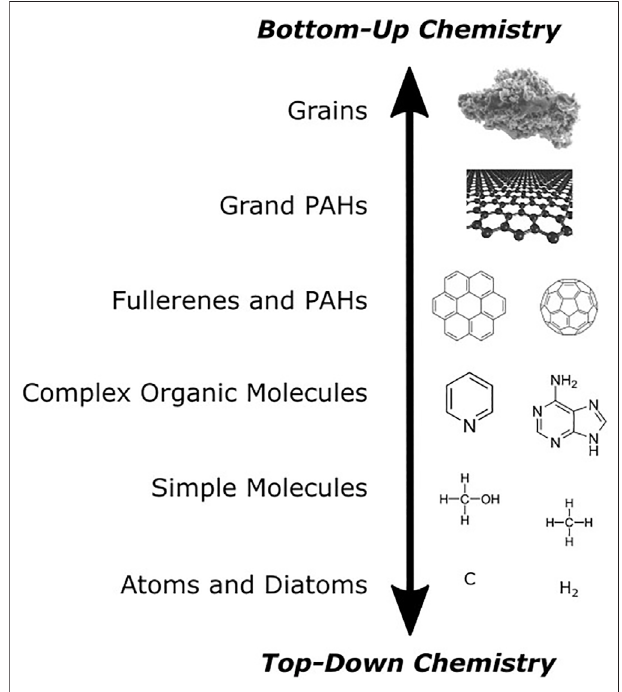
FIGURE 3 | Schematic diagram exhibiting models of “ top-down ” and “ bottom-up ” chemistry using carbon molecules as an example. In the “ bottom-up ” perspective, the association of atoms and simple molecules allows for the formation of larger molecules such as CH 4 and CH 3 OH. Further additions to the molecular structure may result in the formation of a complex organic molecule, such as an aromatic molecule or a PAH. Two- dimensional extension of the PAH structure produces graphite, which itself may be considered the basis of (sub-)micron sized interstellar carbonaceous dust grains. The “ top-down ” chemical perspective is essentially the reverse of this,inwhich largermolecularstructures arebroken upasaresultofenergetic processing, thus yielding simpler